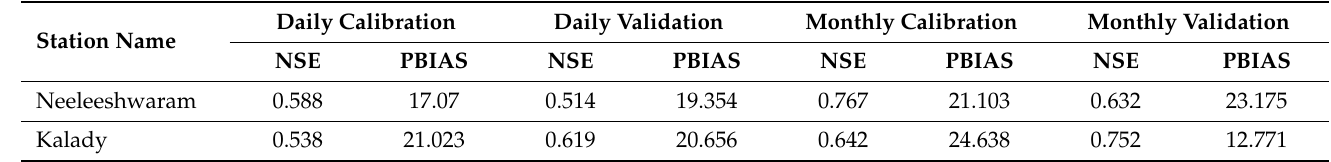
Figure 4. Observed and simulated daily and monthly streamflow’s at the Neeleshwaram and Kalady gauging stations during the calibration and the validation periods. Table 2. NSE and PBIAS values during calibration and